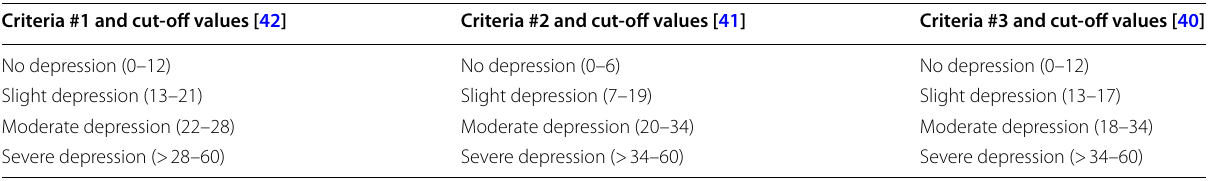
MADRS Montgomery–Åsberg Depression Rating Scale